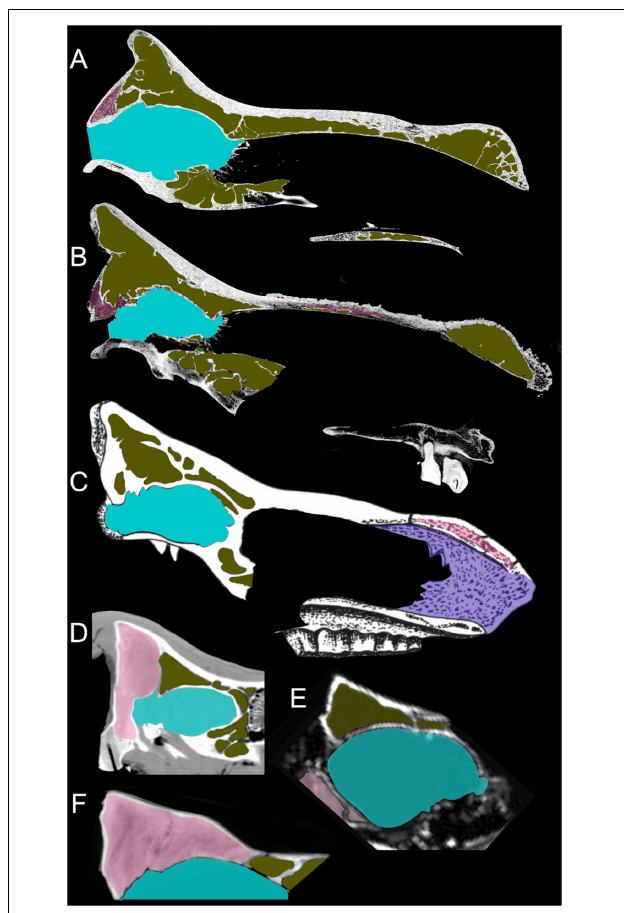
FIGURE 8 | Sagittal section of crania of an adult Diceros bicornis (A) , an adult Ceratotherium simum (B) , an adult Coelodonta antiquitatis (C) – modified from Garutt (1997), a 6-years-old C. simum (D) – modified from Gerard et al. (2018), a 4–5-months-old cub of C. antiquitatis (E) – modified from Protopopov et al. (2015), and the 12–18 months old specimen MPND1082 (F) . The images are not to